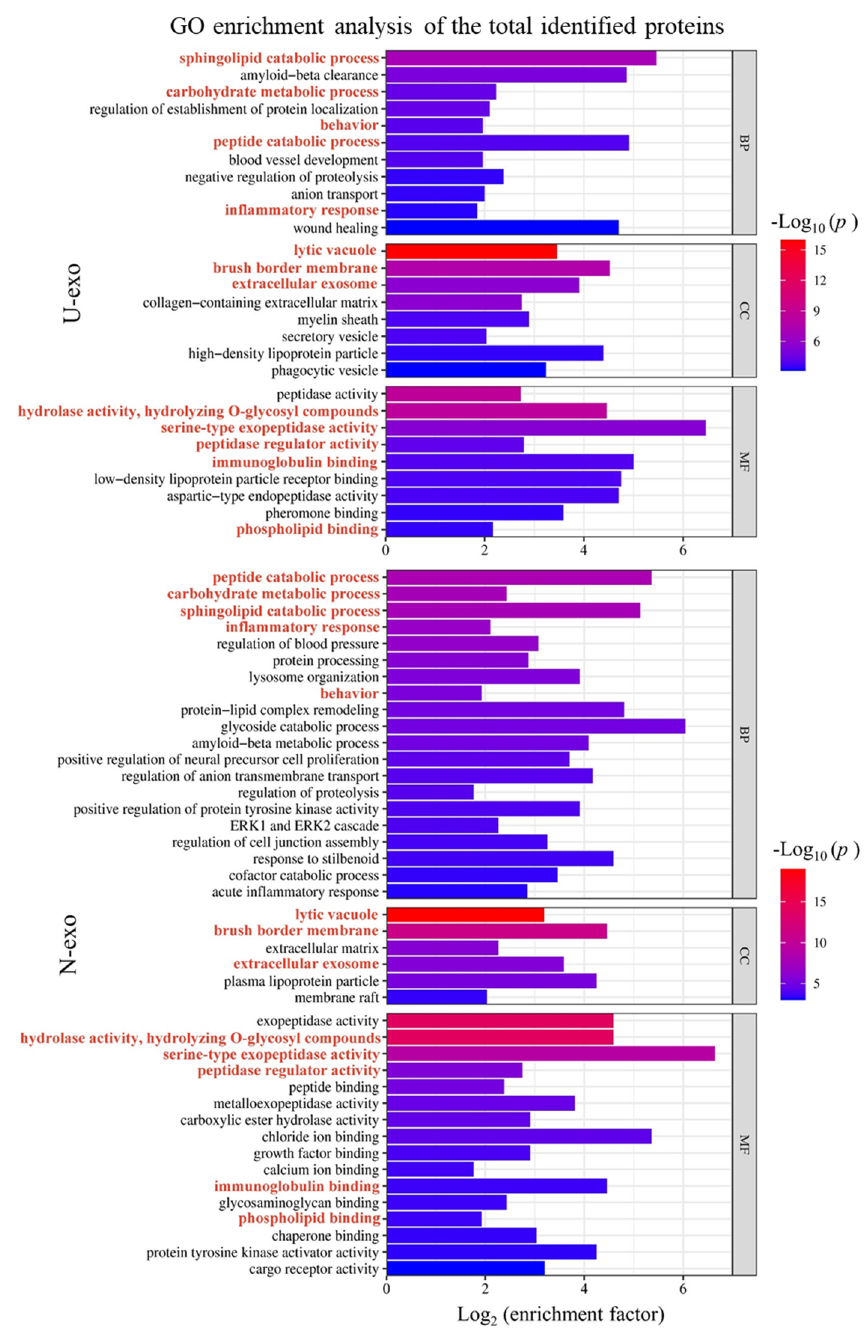
Figure 6. Bar graph for the gene ontology enrichment analysis of the total identified proteins in U-exo and N-exo. We carried out hierarchical clustering analysis on the enriched terms of the identified proteins in U-exo and N-exo. The most statistically significant term (smallest p value) within a cluster is chosen to represent the cluster. Pathway enrichment is measured by p value and enrichment factor. The smaller the p value, the larger the value of the enrichment factor, and the higher the enrichment degree of the corresponding term. The bar color is displayed in a gradient from red to blue, and the enriched BP terms were ranked in descending order of the − Log10 ( p value). The length of the bar represents Log2 (enrichment factor). BP: biological process. CC: cellular component. MF: molecular function. U-exo: urine exosomes. N-exo: neuron-derived